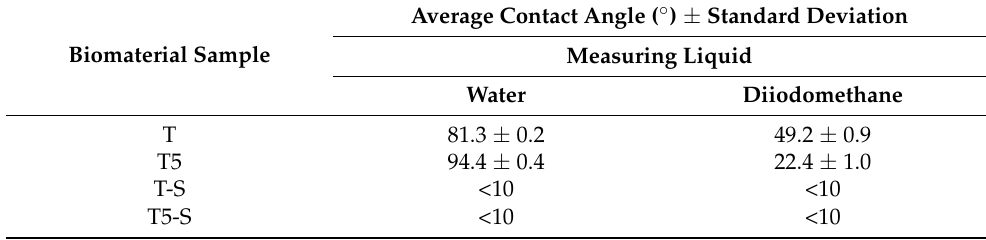
Table 2. The values of contact angles for water and diiodomethane of the T, T5, T-S, and T5-S samples.